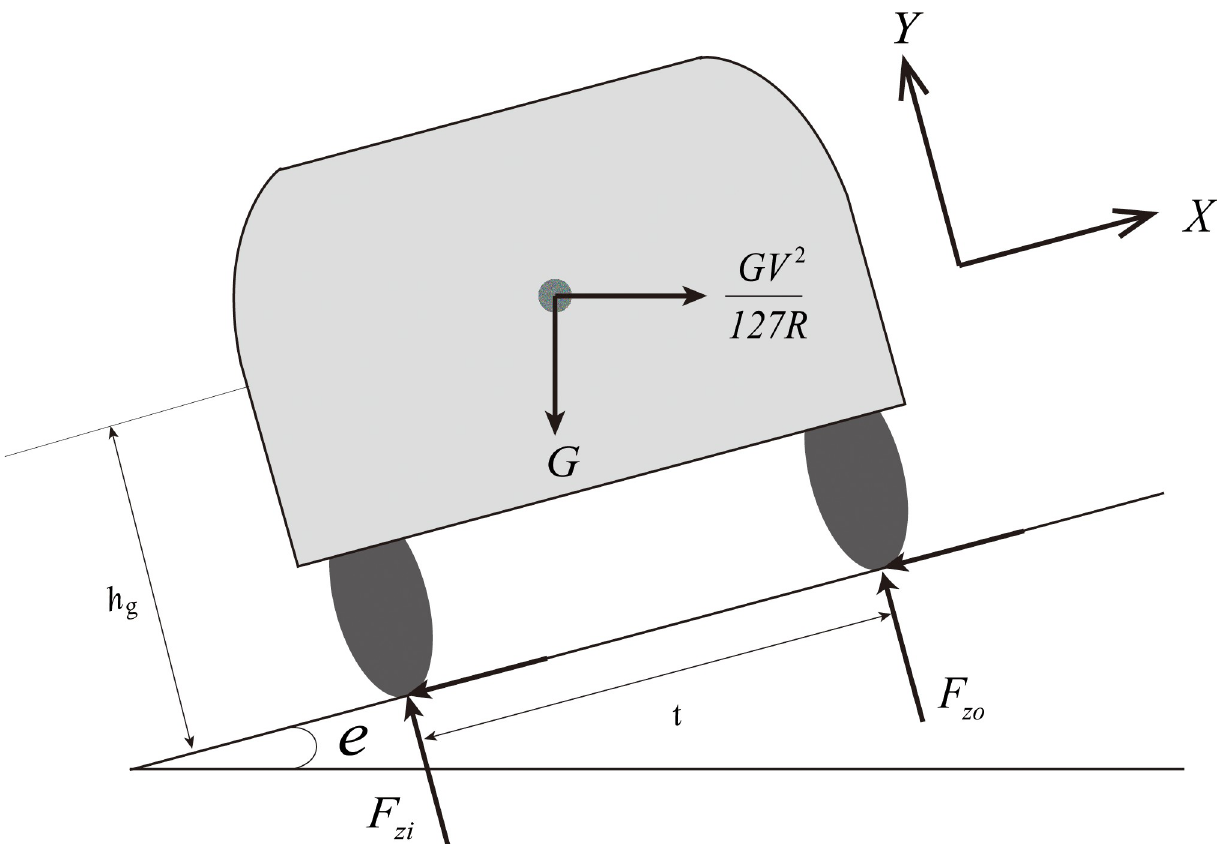
Fig 2. Point-mass